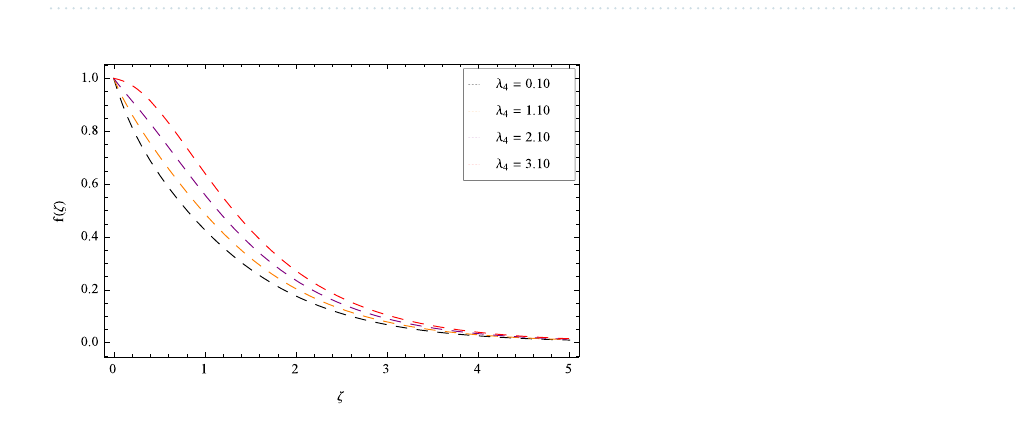
Figure 5. Pattern of graph curves on account of (cid:31) 3 .